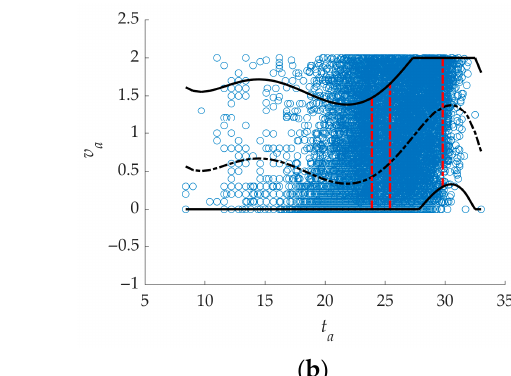
Figure 11. Updating the envelope curve of t a - v a sample points when air velocity was adjustable. ( a ) Air-velocity adjustable update of the envelope curve of the t a - v a sample points (no restriction on maximum and minimum air velocity). ( b ) Air-velocity adjustable update of the envelope curve of the t a - v a sample points (limiting the minimum and maximum air velocity to [0, 2] m/s ). The middle dashed line is the fitting curve of data, the upper and lower two lines of the three curves represent the envelope curve. The lower curve in ( b ) represents the constrained envelope curve with air velocity.